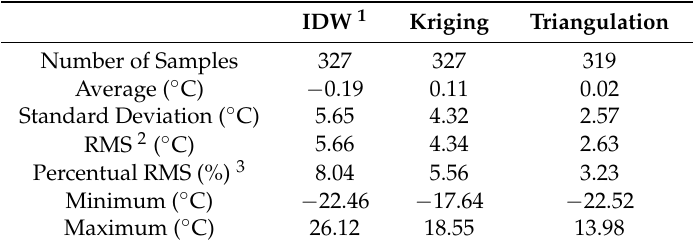
Table 1. Residuals analysis for the interpolation methods used.